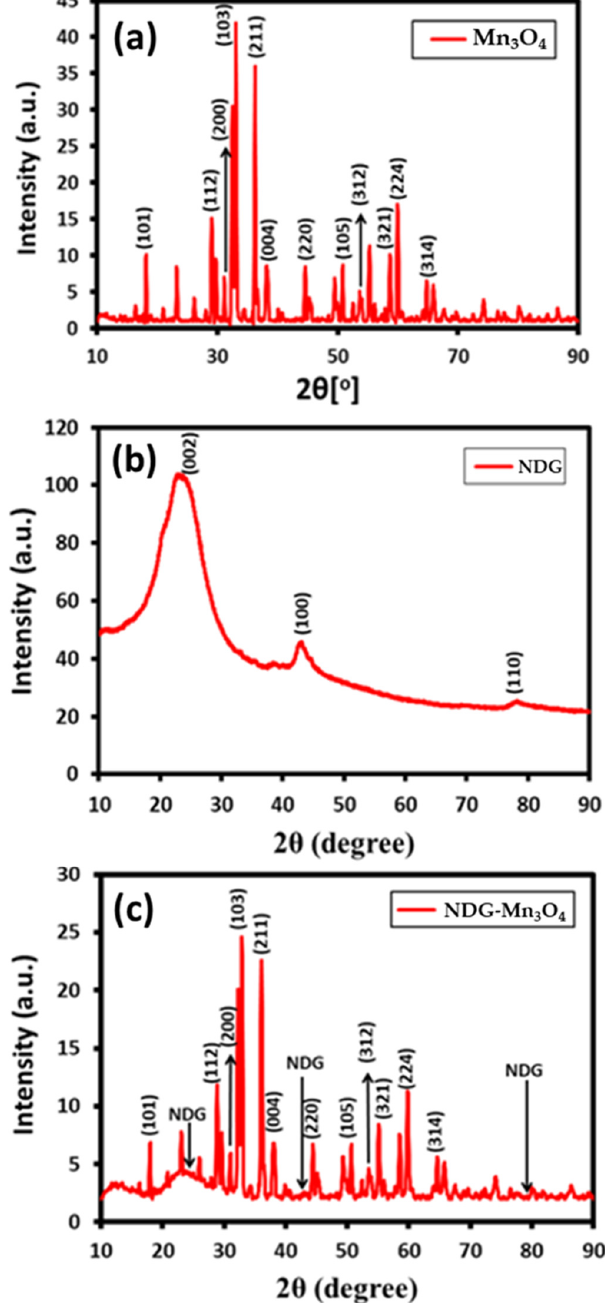
Figure 2. XRD pattern of ( a ) Mn 3 O 4 nanoparticles, ( b ) NDG and ( c ) NDG-Mn 3 O 4 nanocomposite. FT-IR spectra of Mn 3 O 4 NPs displayed the characteristic peak of Mn-O, stretching mode in the range of 624 cm − 1 while the vibrational frequency associated to the Mn-O distortion vibration poisoned at 525 cm − 1 (Figure 3a). The characteristic narrow and broad bands located at 3420 and 1600 cm − 1 were related to the hydroxyl (-OH) groups absorbed by the samples or potassium bromide. FT-IR spectra of NDG are shown in Figure 3b. FT- IR spectra of NDG-Mn 3 O 4 displayed the graphene oxide intense bands for C=C stretching (~1630 cm − 1 ), C–O–C stretching (~1209 cm − 1 ), C–O stretching (~1050 cm − 1 ). The nitrogen doping in the sample was confirmed by the presence of two characteristic peaks at ~1325